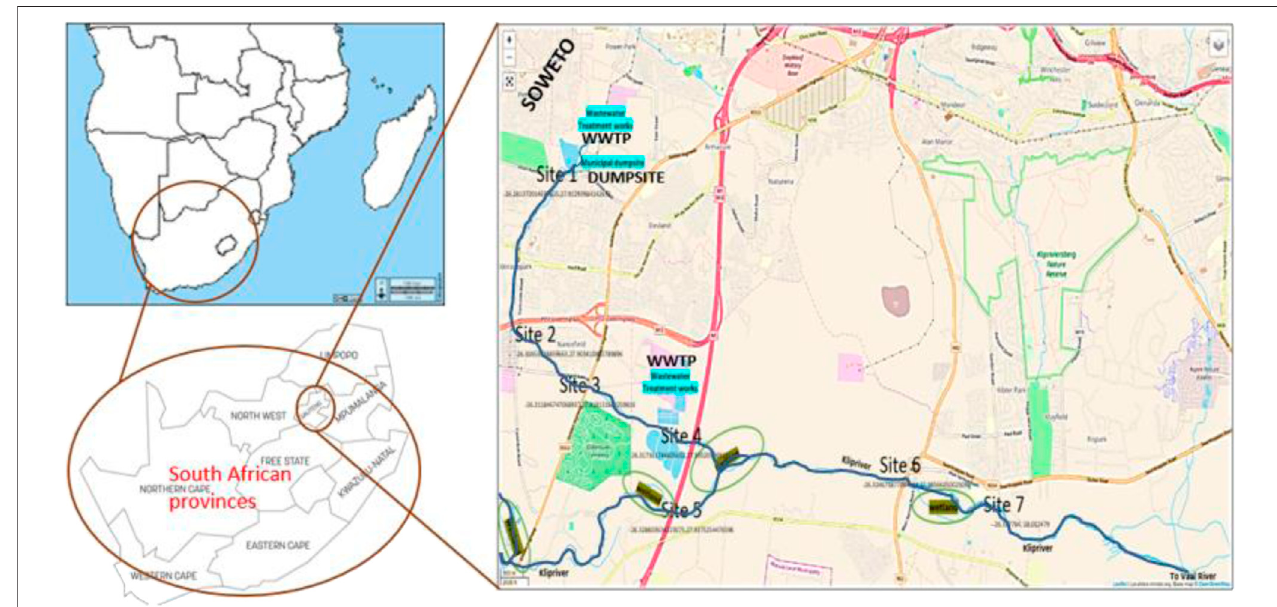
FIGURE 1 | Sampling